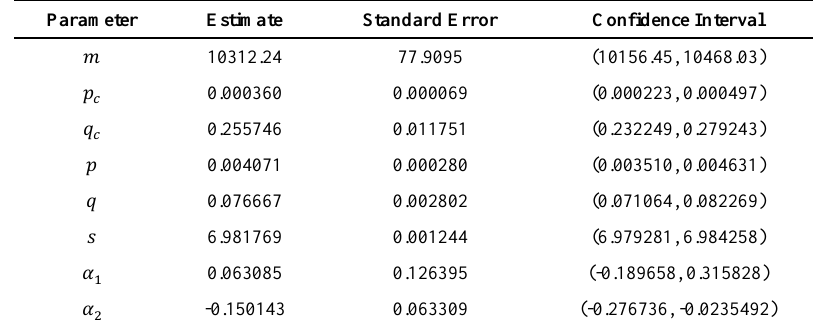
Table 6. Tuscany. Estimates, asymptotic standard errors and 95% mCIs for the parameters of the DMPseas (9)+(10). Parameter